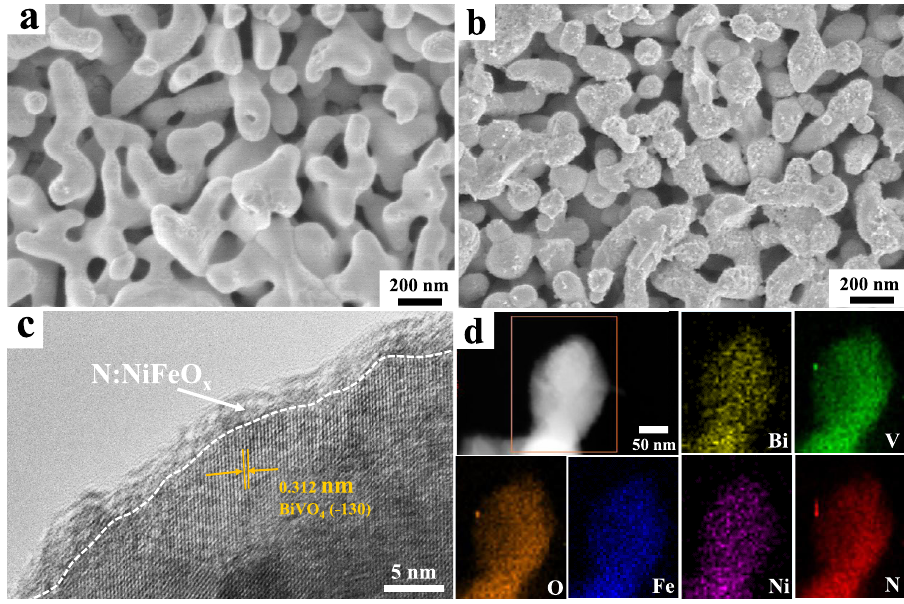
Fig. 1 Morphology and structure characterization of the synthetic photoanodes. SEM images of pristine BiVO 4 ( a ) and BiVO 4 /N:NiFeO x ( b ) photoanodes; HR-TEM image ( c ) and TEM-EDS element mapping analysis ( d ) of BiVO 4 /N:NiFeO x